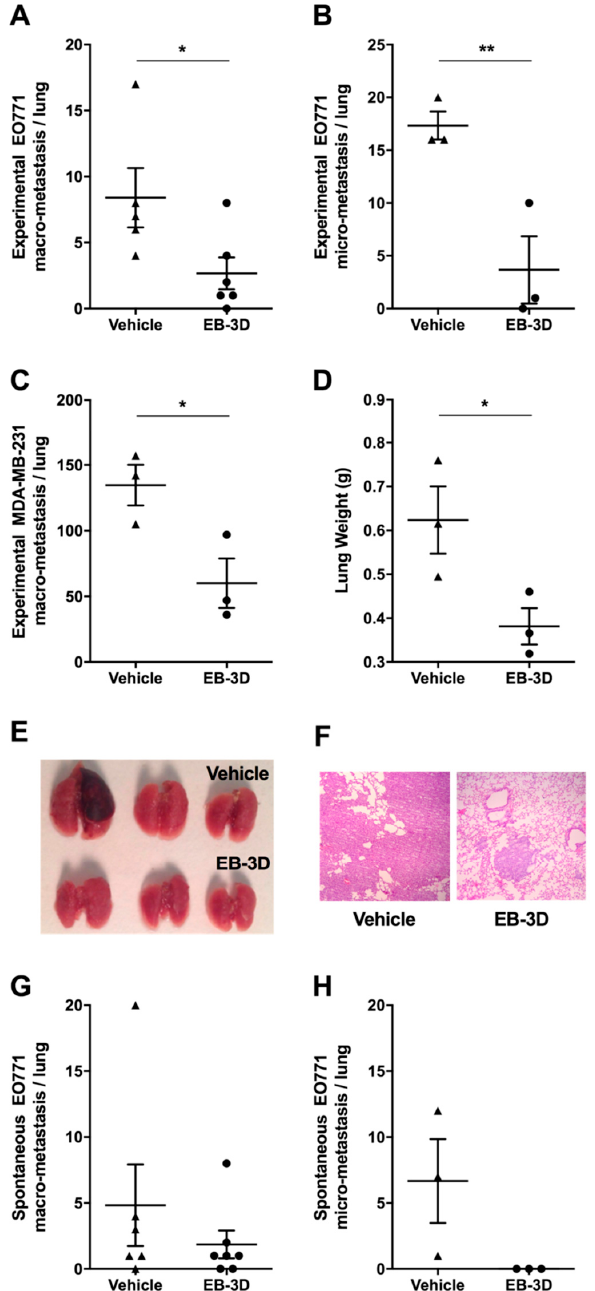
Figure 6. ChoK α inhibition reduces in vivo lung metastasis formation. ( A ) Number of experimentally induced lung macrometastasis and ( B ) micrometastasis after iv injection of E0771 cells and 3 weeks treatment with either vehicle (DMSO, n = 5) or 2.5 mg/kg of EB-3D (n = 6); ( C ) Number of experimentally induced lung macrometastasis after iv injection of human MDA-MB-231 cells in NOD/SCID mice and 7 weeks treatment with either vehicle (DMSO, n = 3) or 2.5 mg/kg of EB-3D (n = 3), ( D ) average lung weight, and ( E ) macroscopic images of resected lungs at the conclusion of the experiment. ( F ) Representative H&E staining performed on lung tissue sections from control and treated xenograft MDA-MB-231-NOD/SCID mice (Magnification 10×). ( G ) Number of spontaneous lung macrometastasis and ( H ) micrometastasis after E0771 primary tumor removal. E0771-C57BL/6 mice were treated intraperitoneally (ip) for 4 weeks every other day with either vehicle (DMSO, n = 5) or 2.5 mg/kg of EB-3D (n = 7). Values are depicted as mean ± SEM. Differences between control and treated mice were analyzed using Student’s t -test with Bonferroni correction. * p < 0.05, ** p < 0.01.